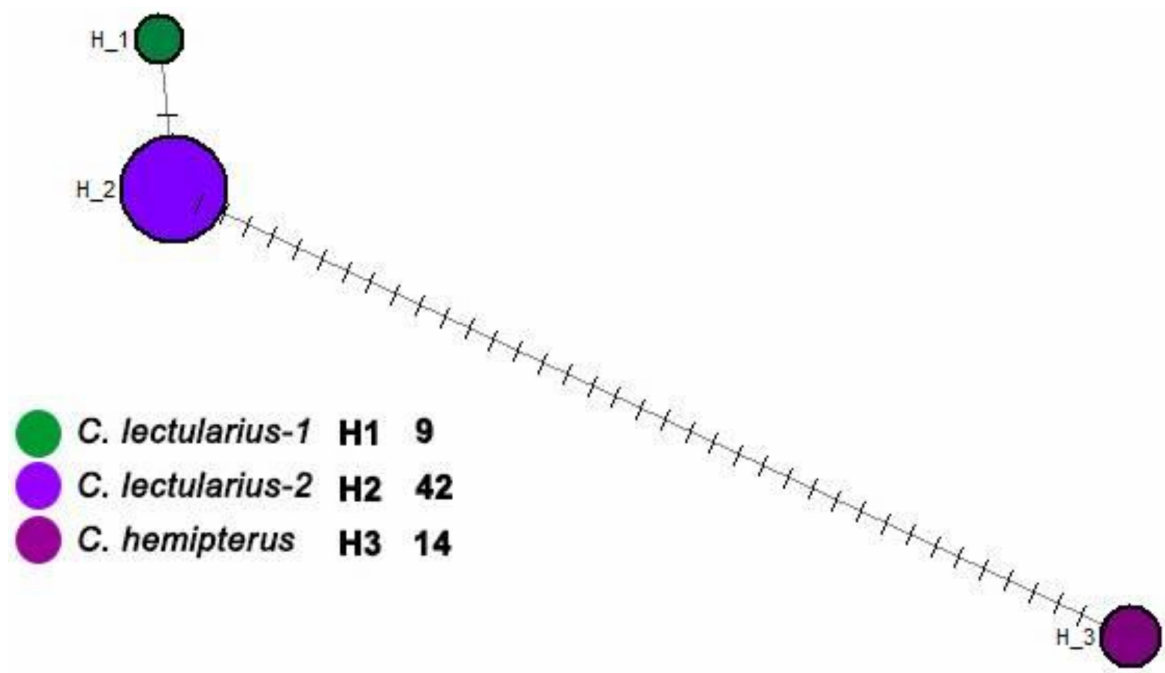
Figure 3. Median-joining network for COI sequences of C. lectularius and C. hemipterous specimens processed in the present study. Table 1. Distribution of COI haplotypes within Cimex species in Paris, France and other countries. Cimex Species